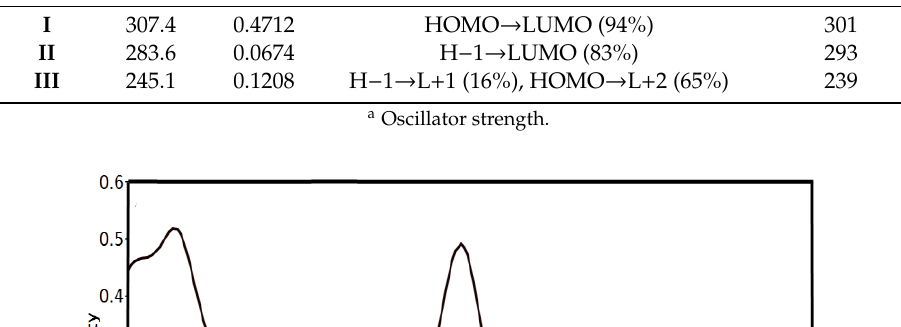
Table 4. The calculated and experimental electronic spectra of the target molecule.